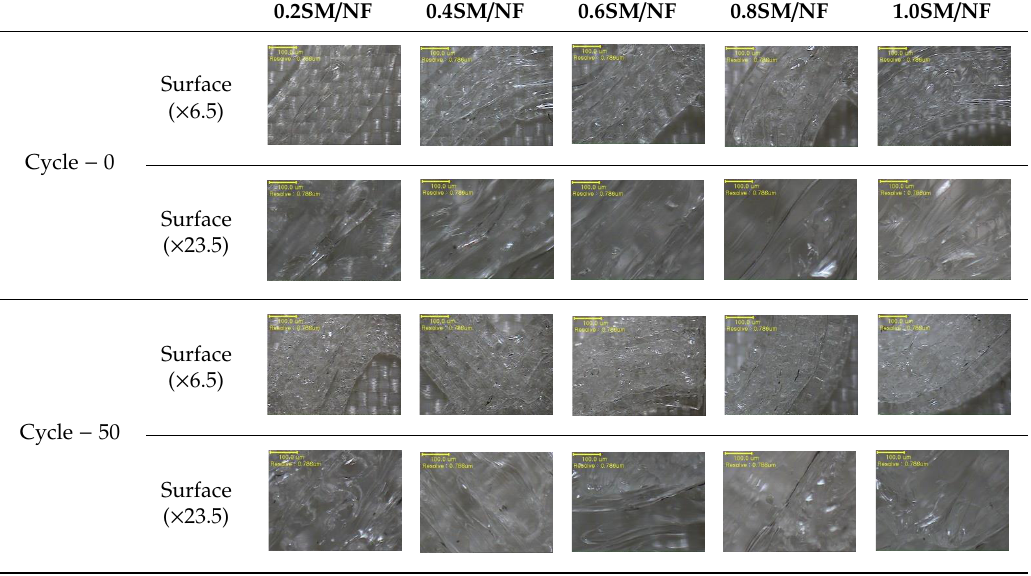
Table 2. Surface morphology of 3D-printed sinusoidal sample/nylon composite with various thicknesses. 0.2SM / NF